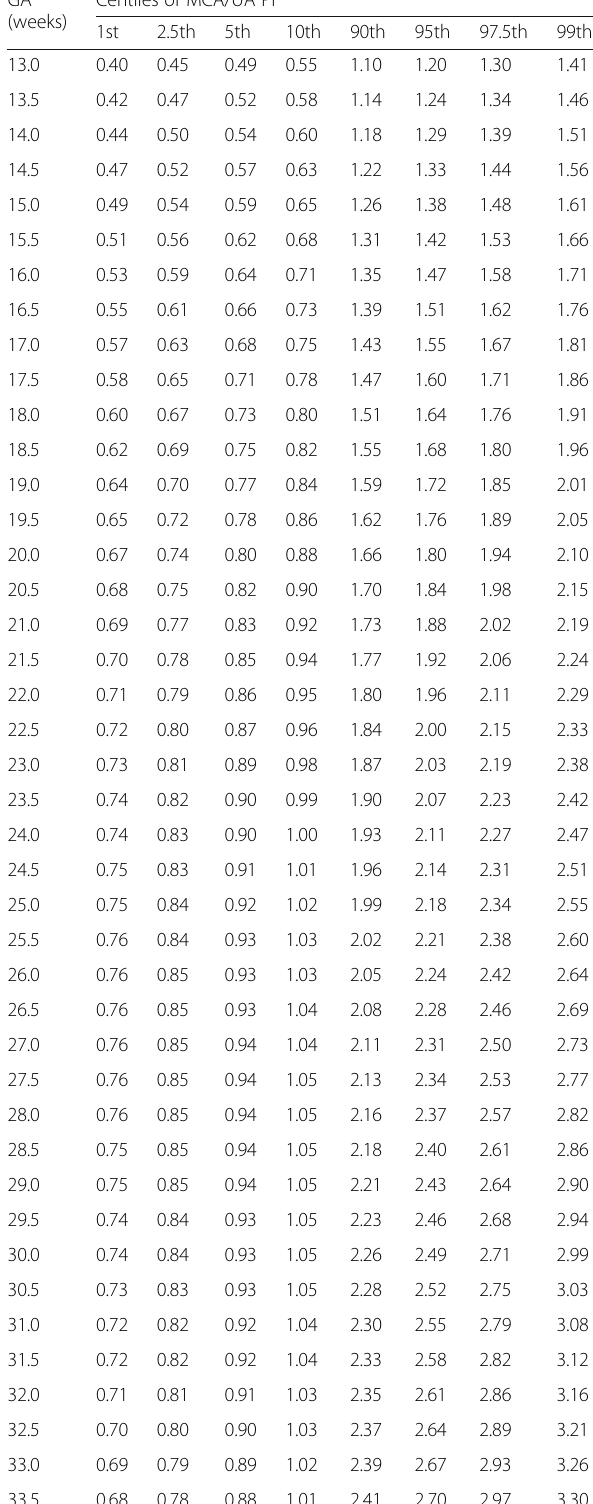
Table 5 Gestational age-defined reference ranges for MCA PI/ UA PI ratio GA Centiles of MCA/UA PI (weeks)